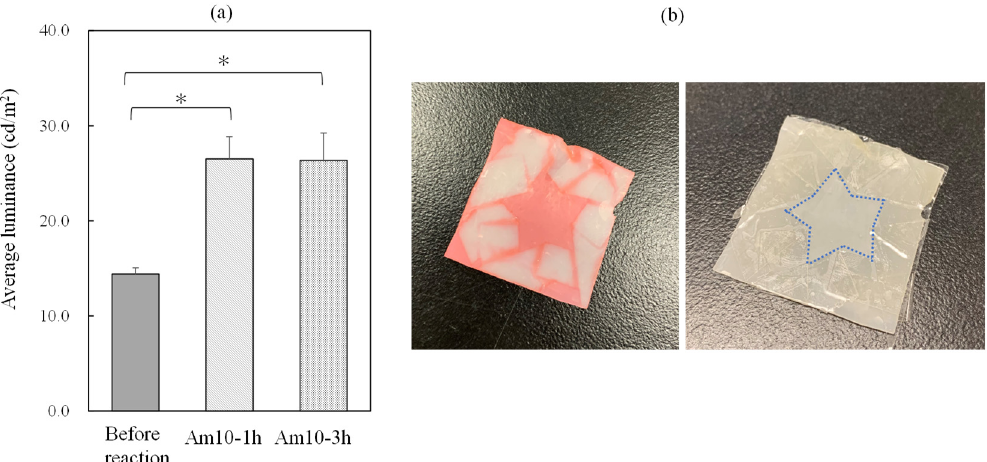
Figure 8. Anionic dye adsorption onto the sample surface before and after reaction with DMEDA. ( a ) Estimation by calculated average luminance. n = 3. ( b ) The dye molecule interaction with selected adsorption area controlled by masking. White area was masked using adhesive tape. *, the results are statistically significant, p < 0.01.